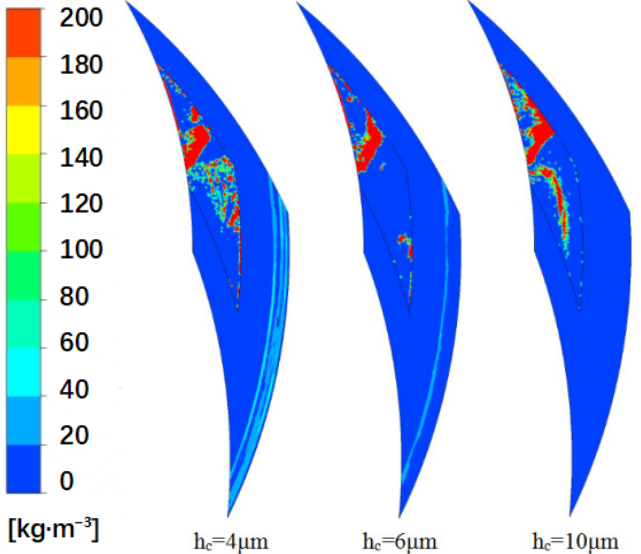
Figure 8. Particles distribution with different groove depths.